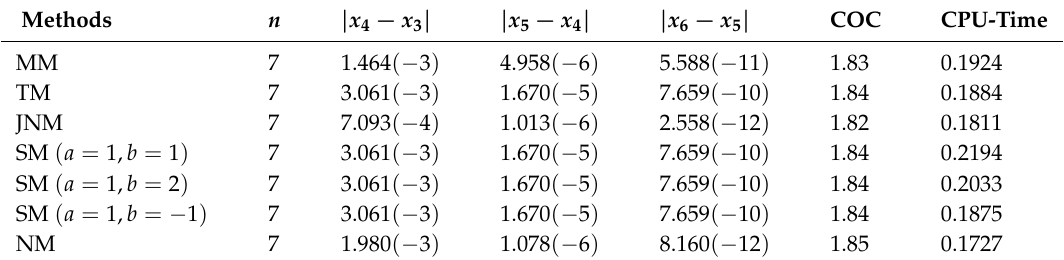
Table 4. Comparison of performance of methods for function f 4 ( x ) , taking x 0 = − 0.4, x 1 = 0.5, x 2 = 0.05.